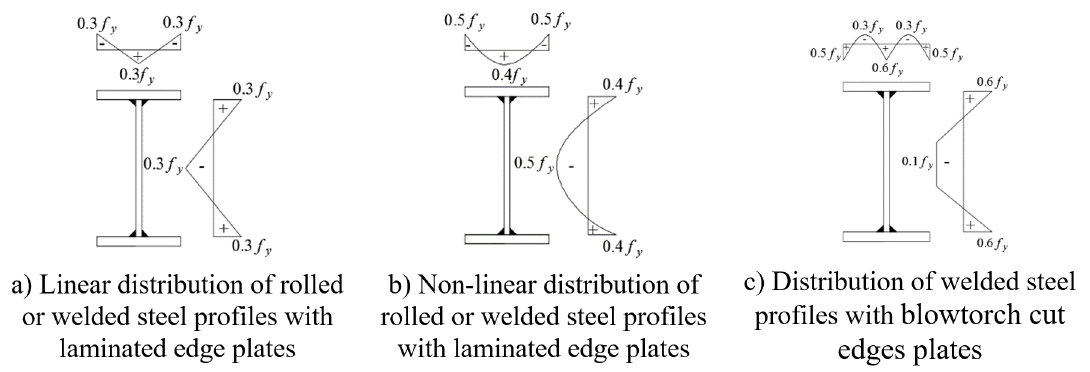
Figure 7. Types of residual stress distributions